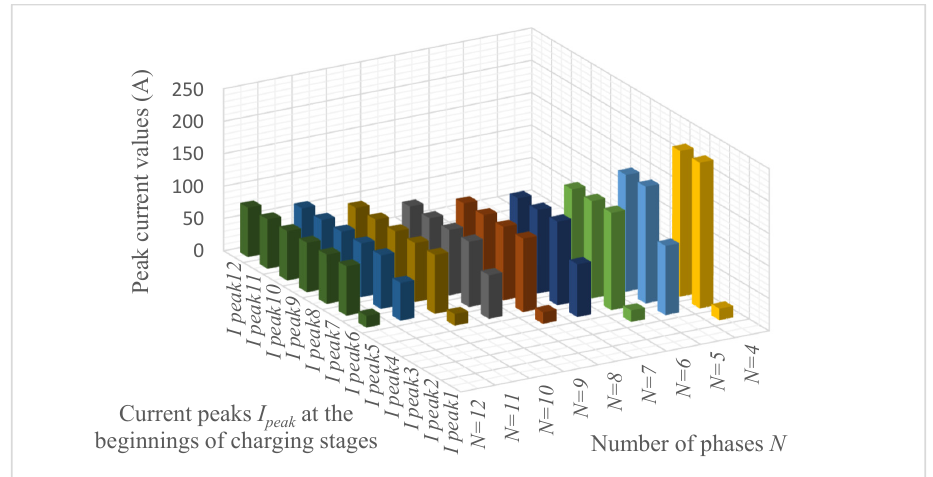
Figure 14. Peak currents of the SC circuit during the operations of certain duty cycles at different numbers of phases.